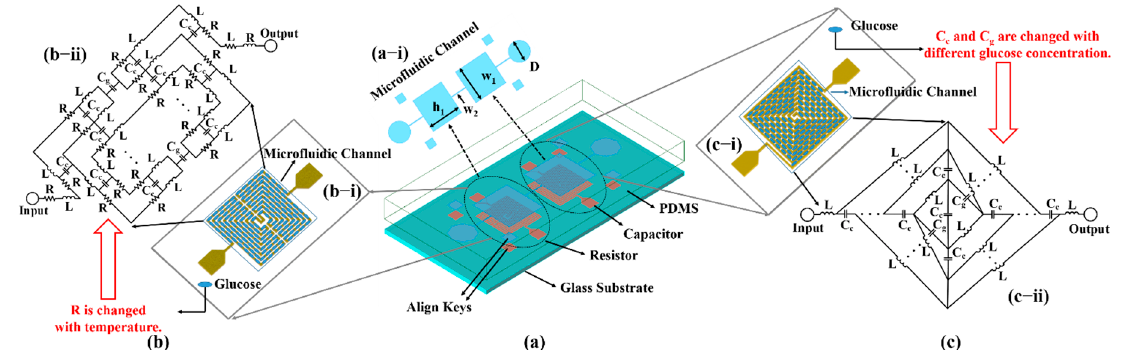
Figure 2. ( a ) Layout of the designed sensor: ( a–i ) shows the PDMS microfluidic channel structure with dimensions in mm, i.e., D = 2.6, w 1 = 4.3, w 2 = 0.1, and h 1 = 4.2. ( b ) The temperature sensor based on resistor structure: The inset image ( b–i ) shows the microfluidic channel inserted with glucose solution; the inset image ( b–ii ) demonstrates the equivalent circuit of the temperature sensor. ( c ) The glucose biosensor based on capacitor structure: The inset image ( c–i ) shows the microfluidic channel inserted with glucose solution; the inset image ( c − ii ) demonstrates the equivalent circuit of glucose biosensor.